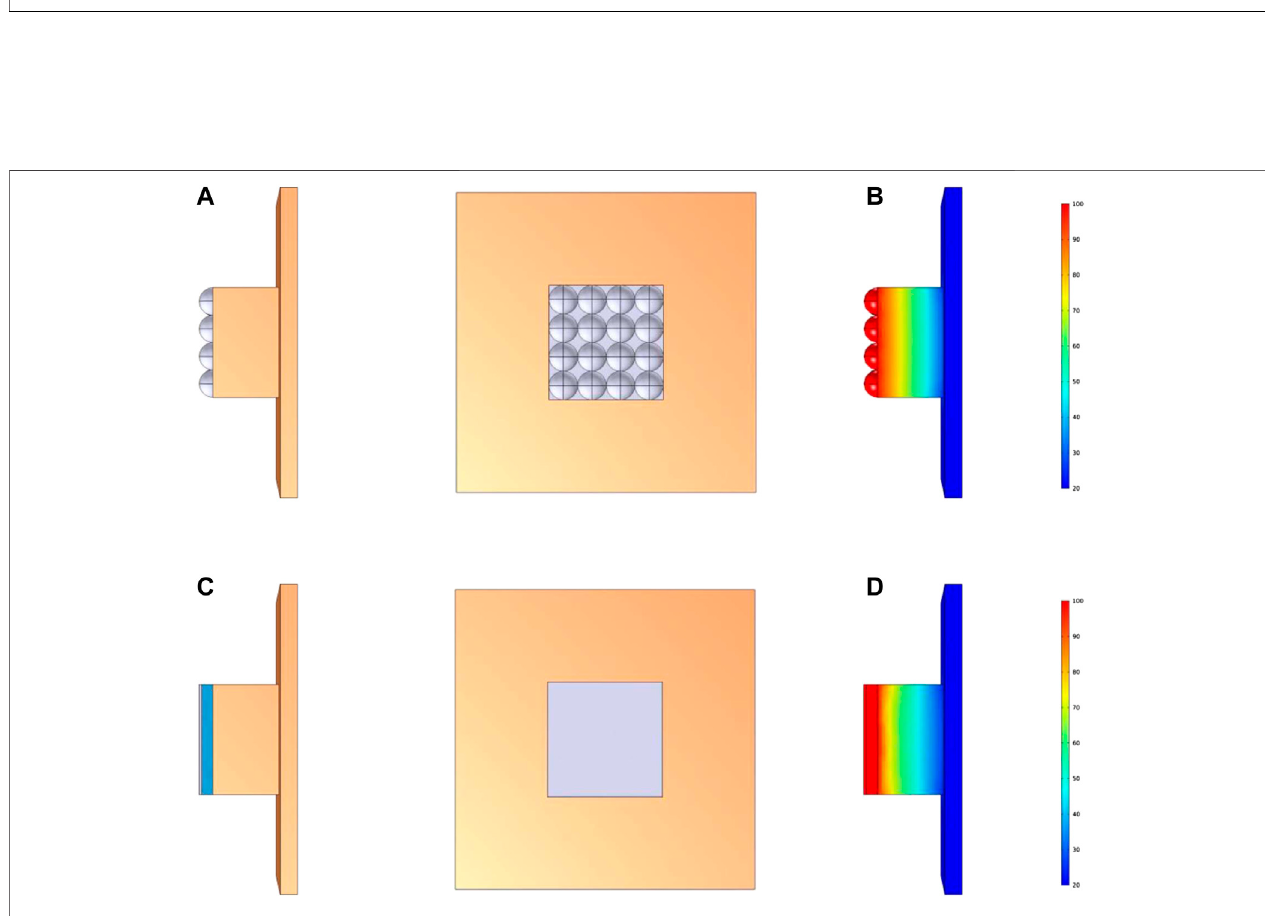
FIGURE 9 | Comparison of simulation modeling between dropwise condensation and fi lm condensation. (A) and (C) are the modeling diagrams of dropwise condensation and fi lm condensation respectively, (B) and (D) are the steady-state temperature fi elds of dropwise condensation and fi lm condensation, respectively.